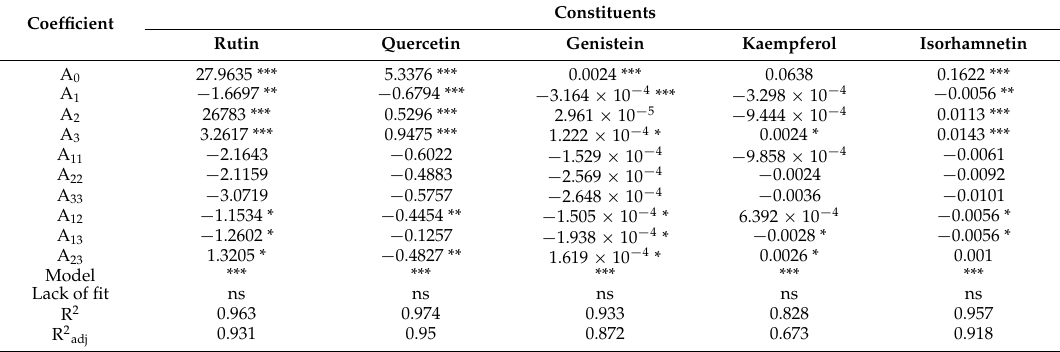
Table 3. Regression coefficients of predicted polynomial models for the investigated responses from FSI extracts.